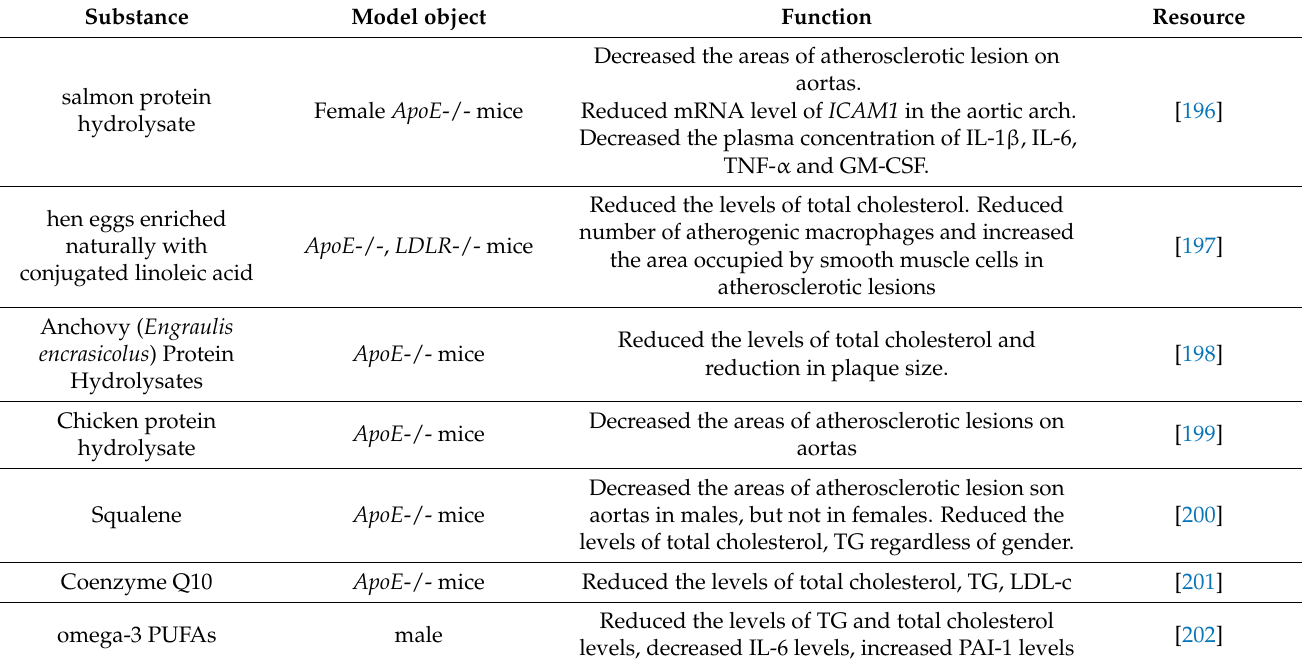
Table 2. BAS—cardioprotectors of non-plant